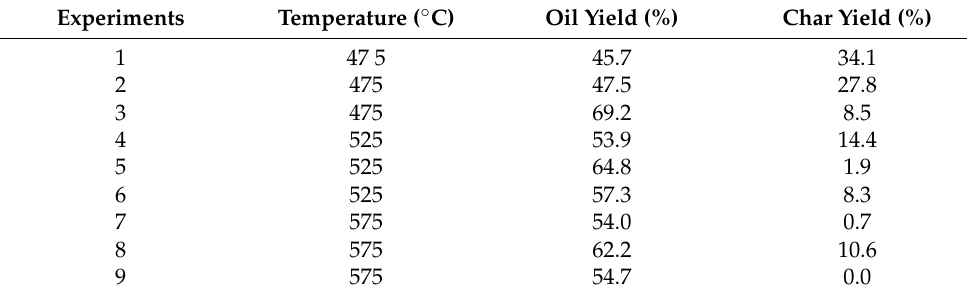
Table 4. PS pyrolysis products’ yield in various